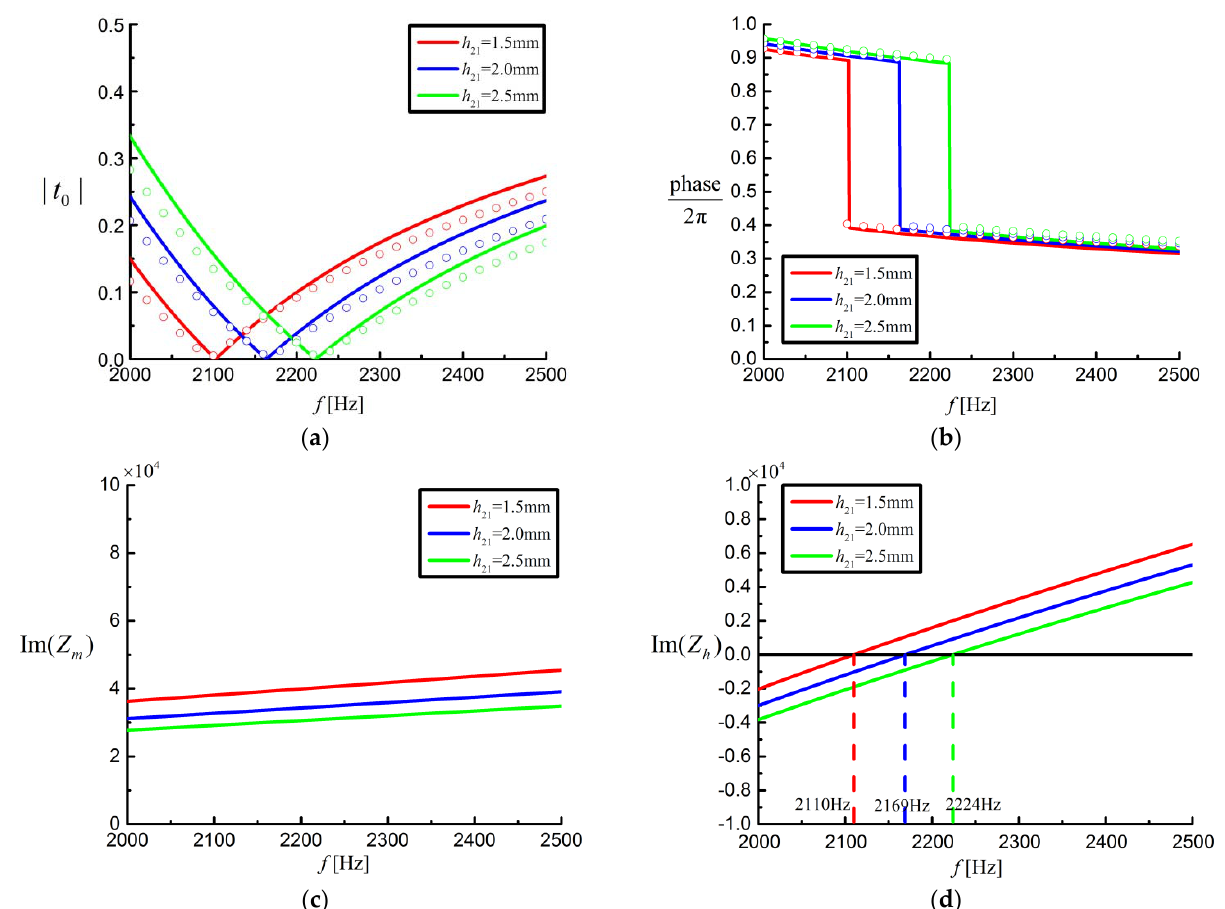
Figure 6. Effects of the width of leak hole h 21 on transmission properties of the DHR device with one leak hole (see Figure 2b). The solid lines correspond to theoretical results, while the circle lines correspond to COMSOL predictions. ( a ) Amplitude vs. frequency; ( b ) Phase shift vs. frequency; ( c ) Impedance of the leak hole vs. frequency; ( d ) Overall impedance of the DHR device vs. frequency.